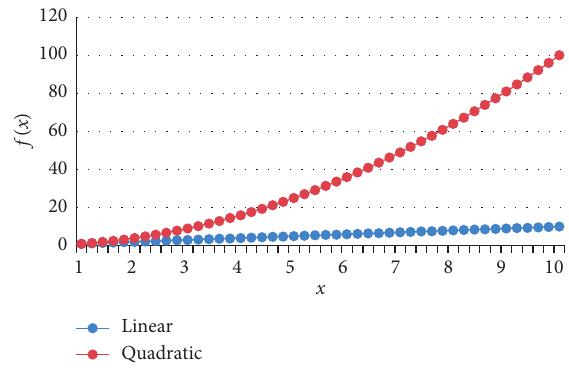
Figure 16: The comparison of linear and quadratic